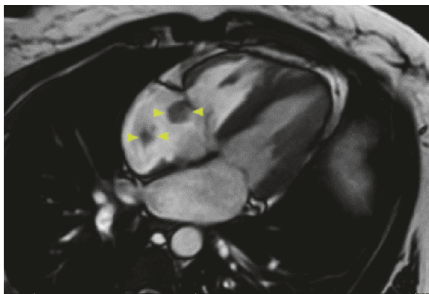
Figure 3: Cardiac MRI image showing multiple right atrial